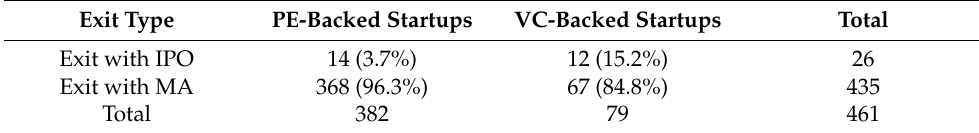
Table 8. PE and VC-backed Startups by IPO and M&A Exits Type.